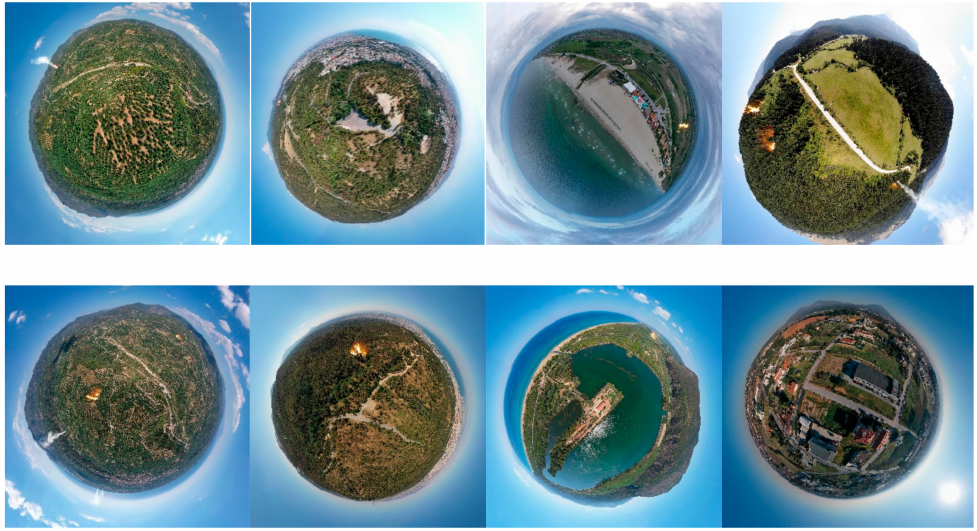
Figure 2. Sample testing images of the “Fire detection 360-degree